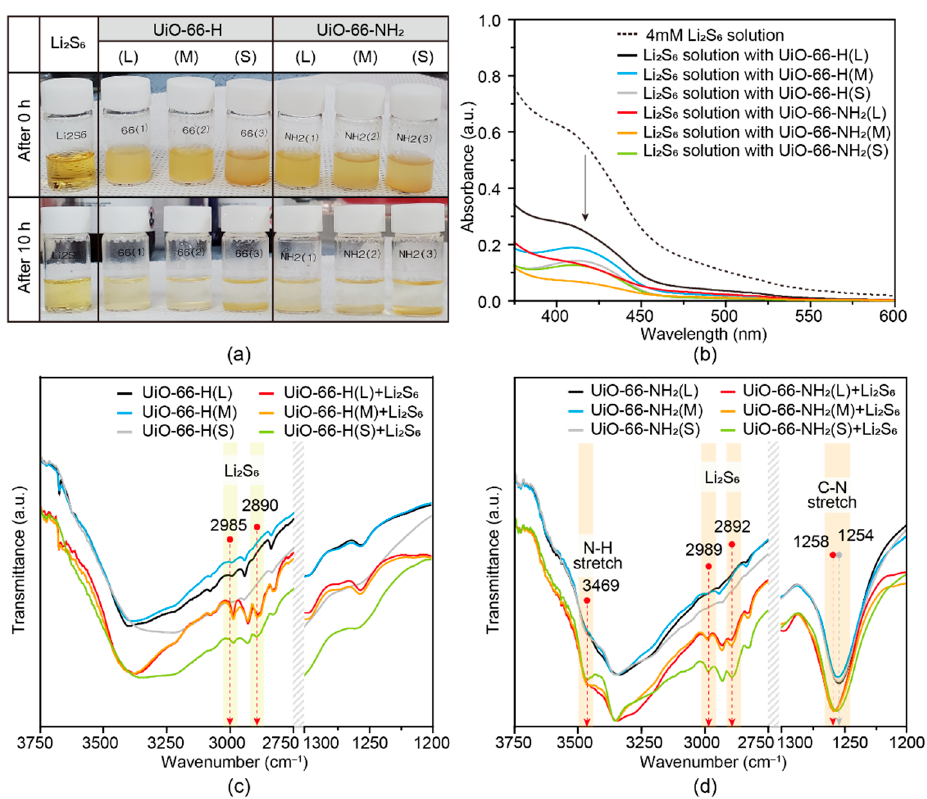
Figure 3. Li 2 S 6 absorption analysis of UiO-66-H(X) and UiO-66-NH 2 (X) powders: ( a ) Digital image of 4 mM Li 2 S 6 solution before and after soaking UiO-66-H(X) and UiO-66-NH 2 (X) powders for visual absorbing analysis; ( b ) UV-visible spectra of Li 2 S 6 solution before and after 10 h treatment with UiO-66-H(X) and UiO-66-NH 2 (X). FT-IR spectra of: ( c ) UiO-66-H(X) and ( d ) UiO-66-NH 2 (X) before and after absorbing Li 2 S 6 .